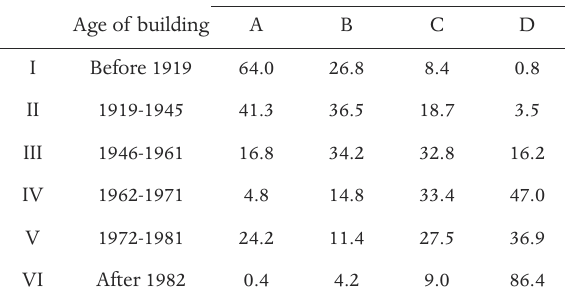
Table 1. Distribution matrix of the vulnerability classes EMS98 with the reference to the age of building, taken from Zuccaro et al.